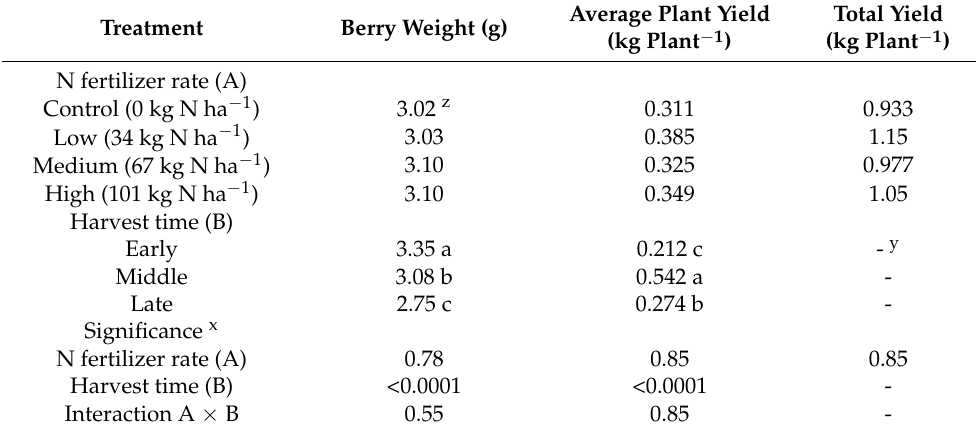
Table 2. Berry weight, average plant yield, and total yield of the “Meeker” floricane red raspberry fertilized with different nitrogen (N) fertilizer rates,